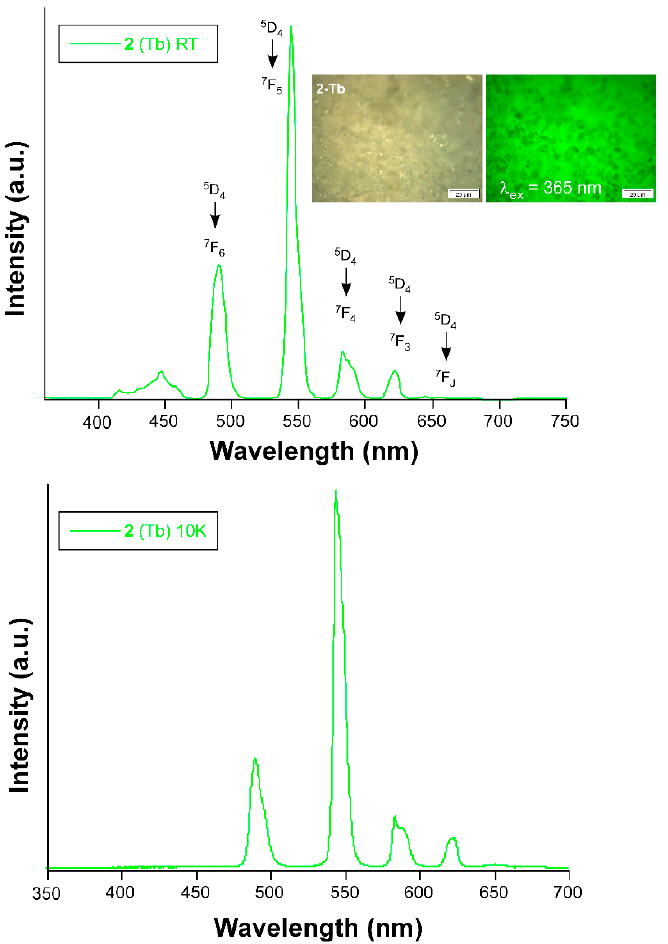
Figure 7. Emission spectra of compound 2 recorded at room (top) and low temperature (bottom).